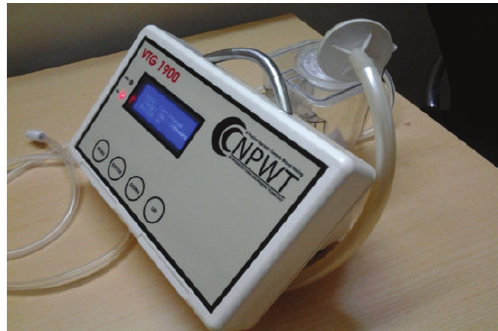
Figure 4: The connecting tube was connected to the negative pres- sure wound therapy.